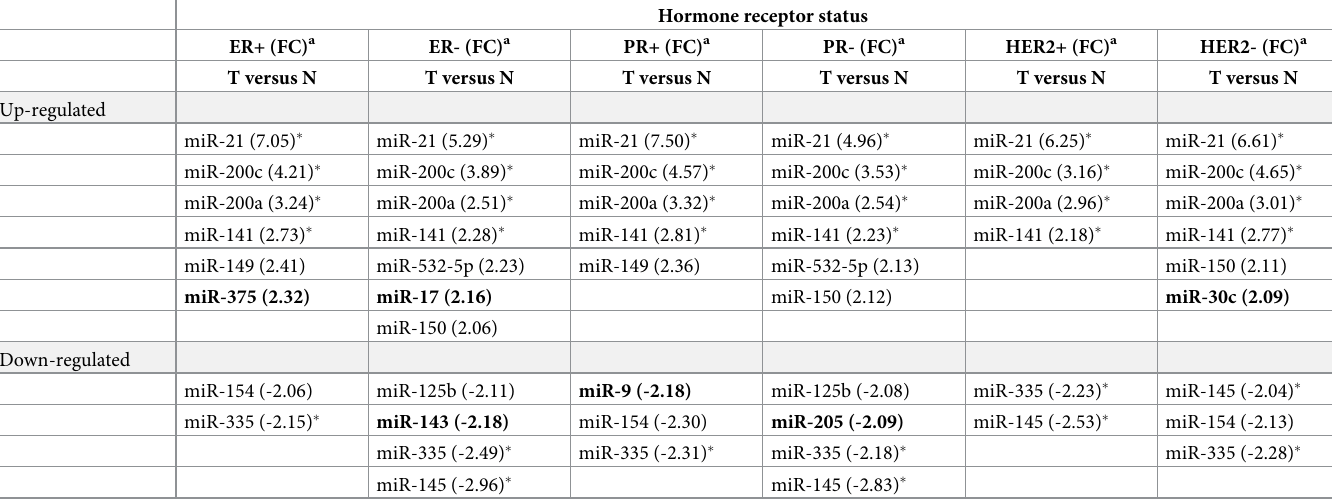
Table 7. Differential expression of miRNAs in specific receptor expression status.